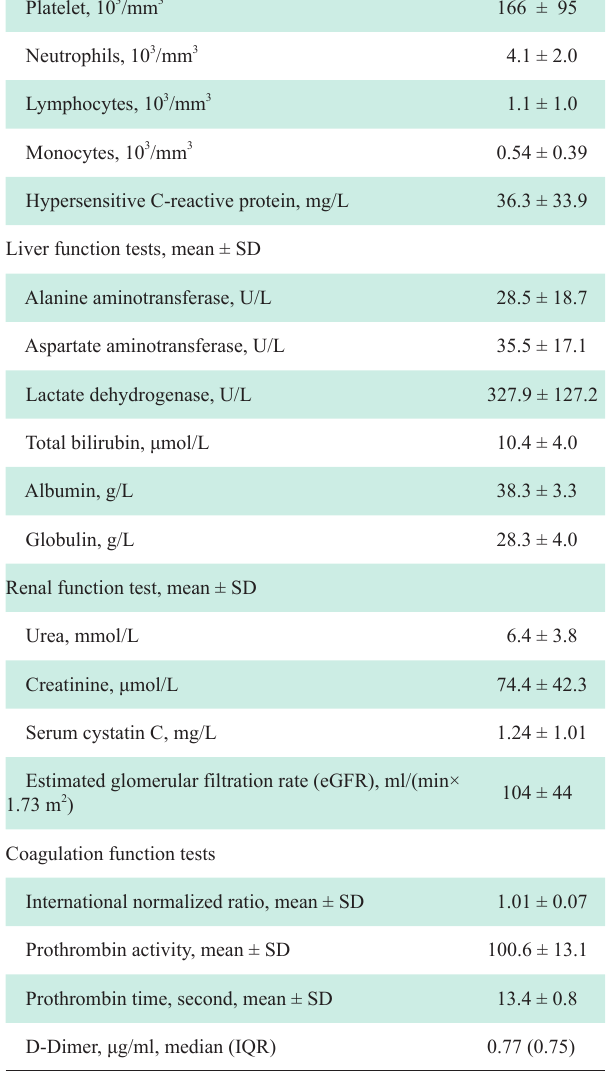
Table 3 Chest CT imaging in 27 COVID-19